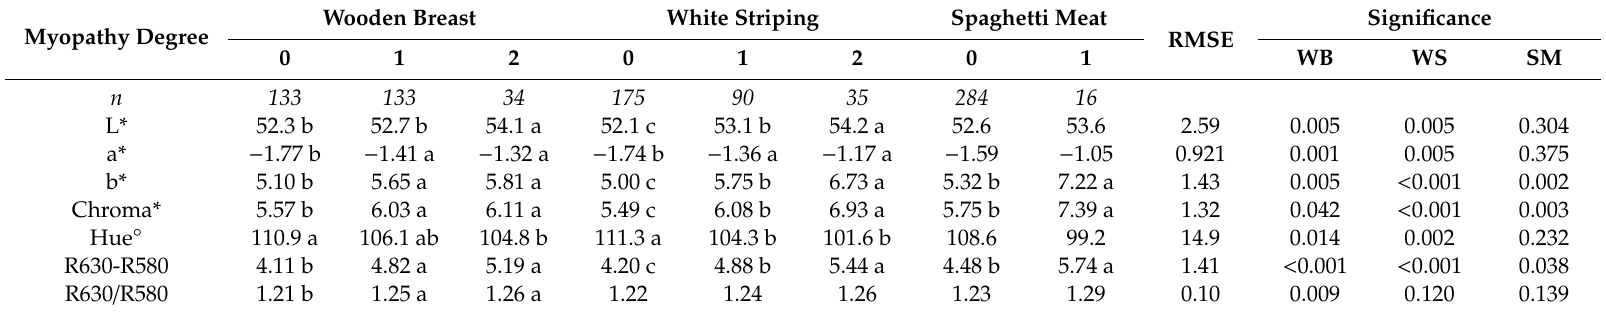
Table 2. Color of the surface of broiler breast with di ff erent degree of myopathies. Wooden Breast